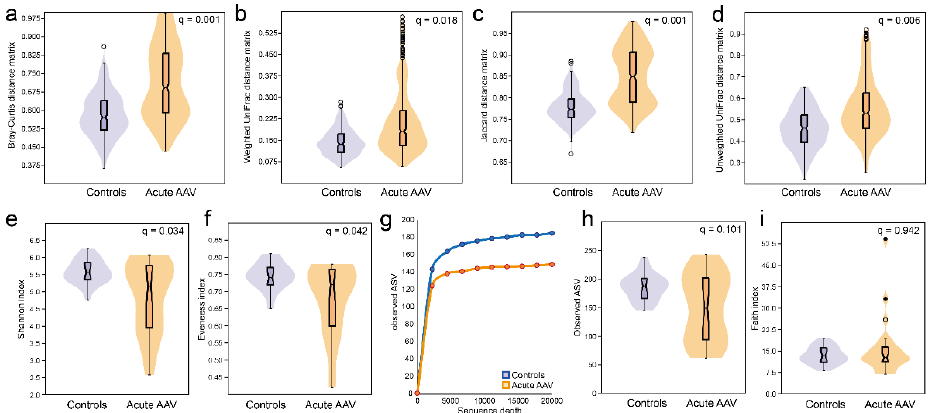
Figure 3. Diversity measures of saliva microbiota in acute AAV and control individuals. Violin plots illustrating beta-diversity based on ( a ) quantitative phylogeny measures by the Bray–Curtis distance matrix ( q = 0.001) or ( b ) Weighted UniFrac distance matrix ( q = 0.018) or qualitative measures ( c ) without phylogeny by the Jaccard distance matrix ( q = 0.001) or ( d ) with phylogeny by the Un- weighted UniFrac distance matrix ( q = 0.006). Alpha-diversities for ( e ) richness and evenness (Shan- non index, q = 0.034), ( f ) evenness (Evenness index, q = 0.042), ( g ) the number of ASVs at different sequencing depths, ( h ) violin plots with box plots for the total number of ASVs at 20,000-read se- quencing depth, and ( i ) phylogenetically (Faith index, q = 0.942).